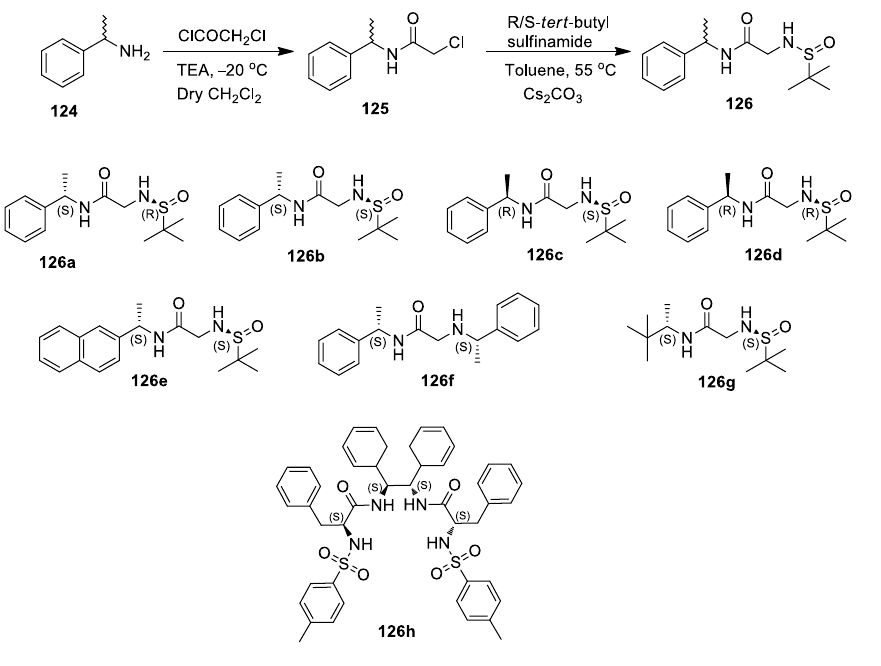
Scheme 37. Synthesis of chiral sulfinamide organocatalysts 126a–126h .